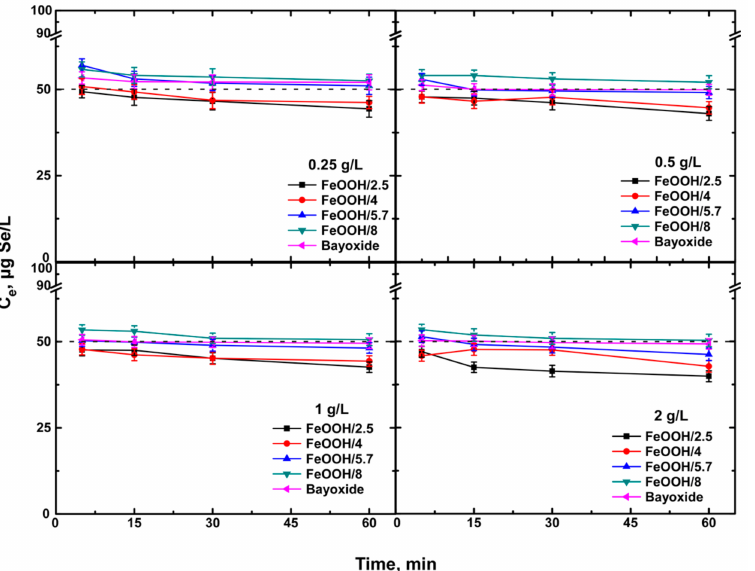
Figure 4. Adsorption of selenium species onto several FeOOHs materials in relation to adsorbent dose and to contact time. Experimental conditions: the initial concentration of samples is a mixture containing 50 µ g Se(IV)/L and 50 µ g Se(VI)/L (i.e., total Se 100 µ g/L), at pH 7.3 ± 0.2 and temperature 20 ◦